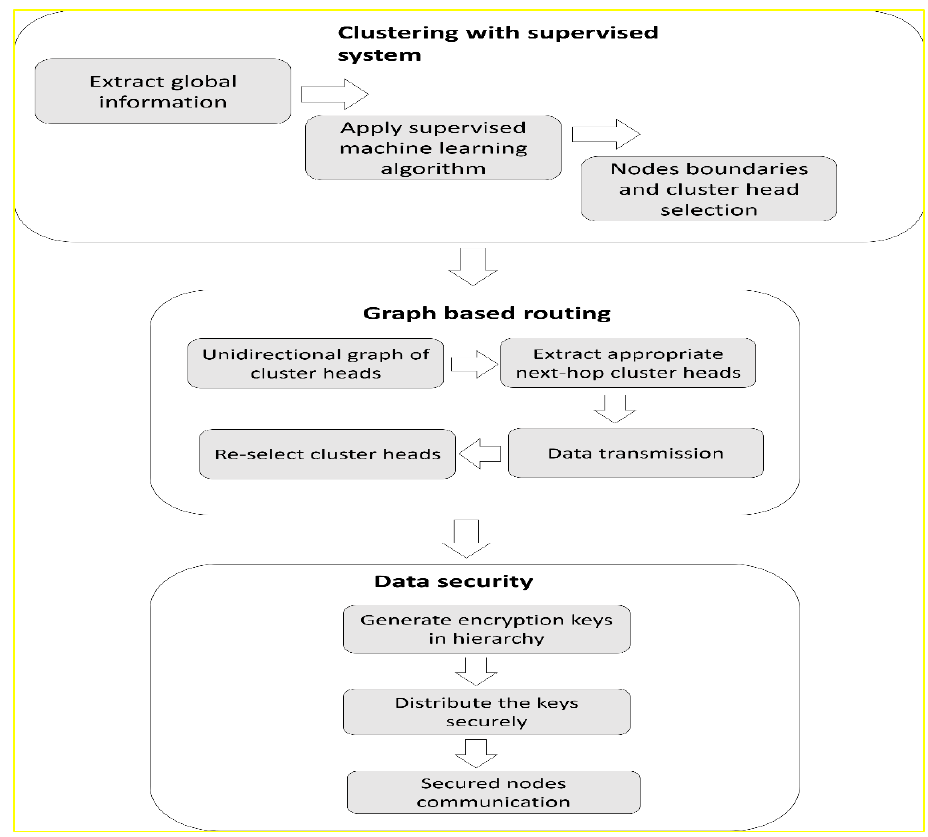
Figure 1. Research design of energy-aware graph clustering and intelligent routing using a supervised Figure1. system.